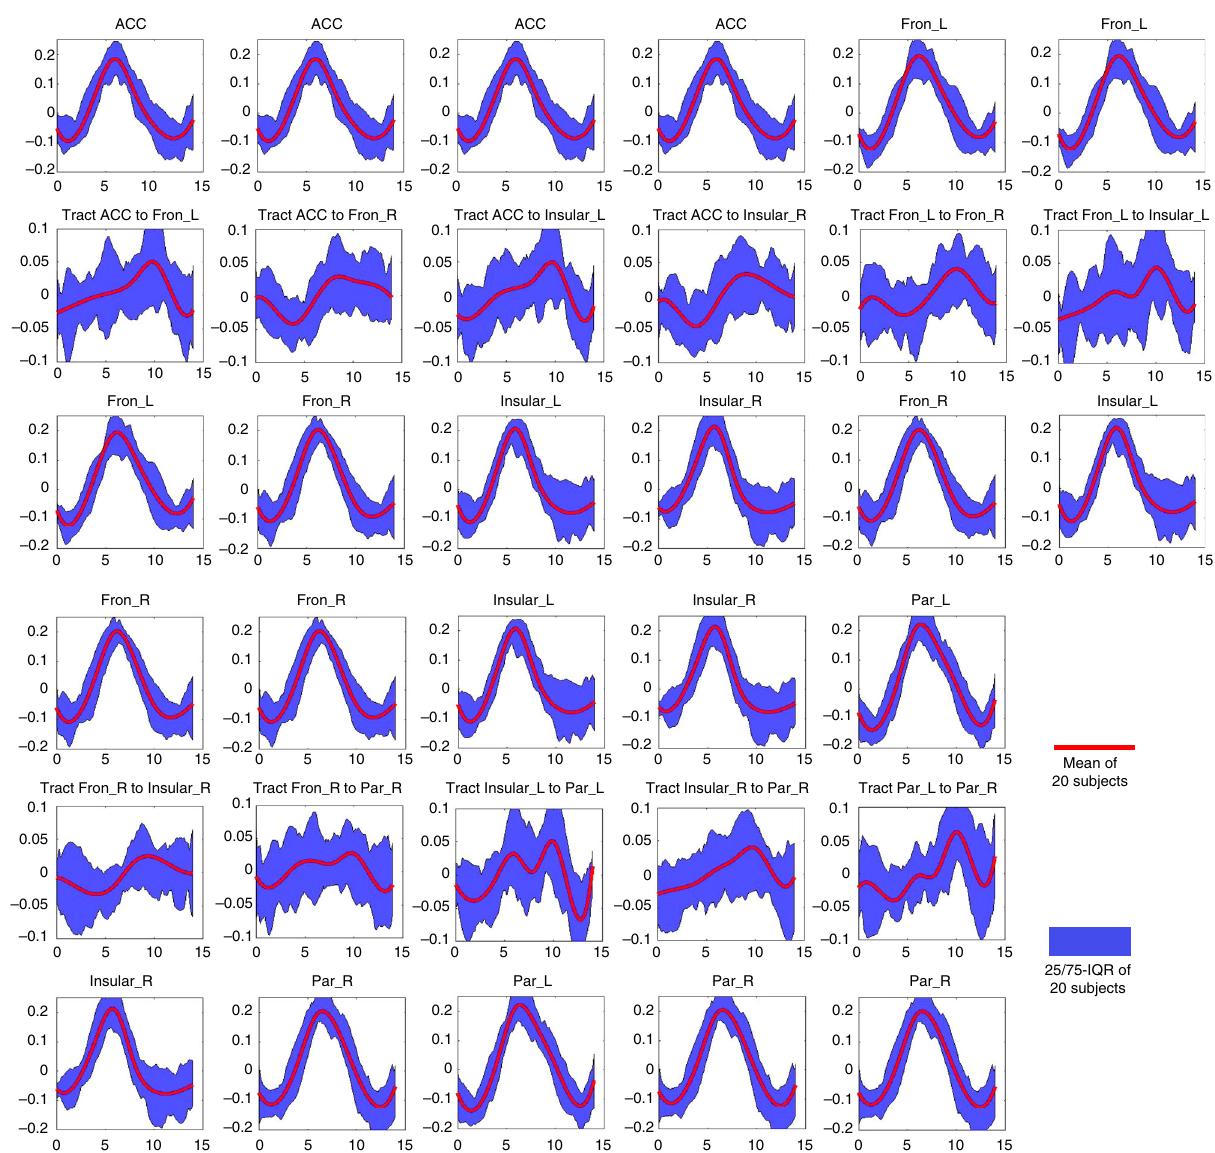
Fig. 3 Average time courses in WM tracts and their connecting GM clusters. The time course of a WM tract was displayed in the center of each panel with the time courses of its connecting GM clusters vertically aligned at the top and bottom. The x -axis is the time (seconds), y -axis is the signal intensity (a.u.). Time = 0 is aligned to the onset of each incongruent stimulus. IQR = Interquartile Range. Source data are provided as a Source Data fi